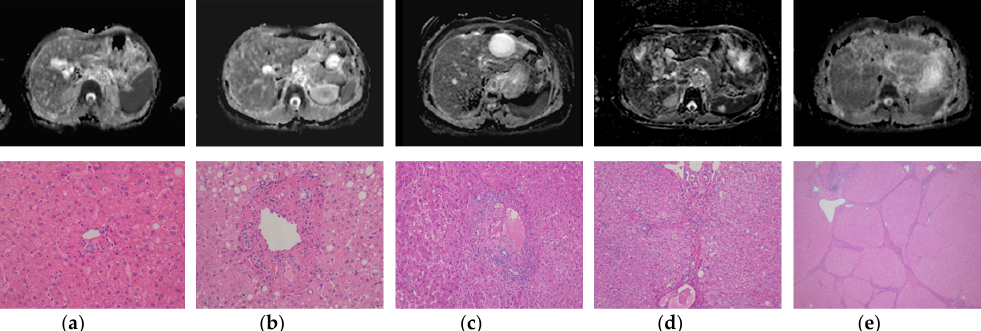
Figure 1. Magnetic resonance imaging (apparent diffusion coefficient (ADC) map, upper row) and histologic findings (H&E stain, lower row) matched for each stages of liver fibrosis. ( a ) No liver fibrosis (F0), magnification × 400. ADC liver was 1.389 × 10 − 3 mm 2 / s and nADC liver was 1.977. ( b ) Portal fibrosis (F1), magnification × 400. ADC liver was 1.091 × 10 − 3 mm 2 / s and nADC liver was 1.327. ( c ) Periportal fibrosis (F2), magnification × 400. ADC liver was 1.376 × 10 − 3 mm 2 / s and nADC liver was 1.416. ( d ) Septal fibrosis(F3), magnification × 200. ADC liver was0.963 × 10 − 3 mm 2 / sand nADC liver was1.29. ( e ) Cirrhosis (F4), magnification × 20. ADC liver was 1.278 × 10 − 3 mm 2 / s and nADC liver was